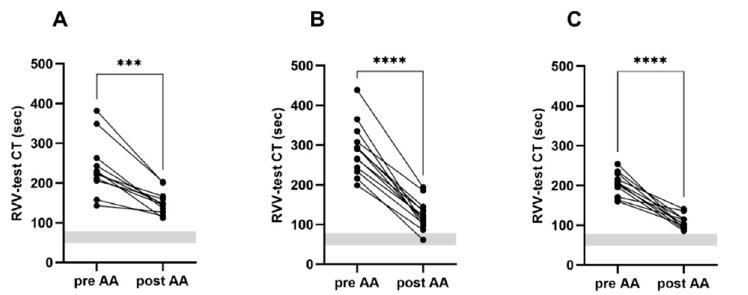
Figure 3. ClotPro ® RVV-test CT before and after spiking with the specific factor Xa-inhibitor Andex- anet alfa. ( A ) Apixaban, ( B ) edoxaban, ( C ) rivaroxaban. AA: Andexanet alfa; CT: Clotting time; RVV- test: Russell’s viper venom assay; the gray area represents normal limits of the specific test. *** p < 0.001; **** p < 0.0001, paired t-test. *** p < 0.001; **** p < 0.0001, paired t